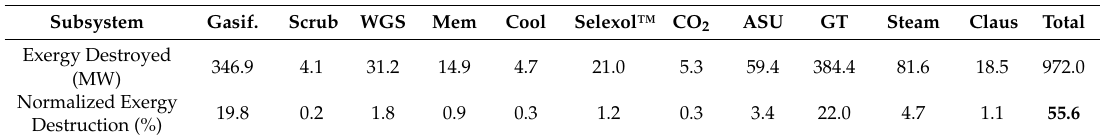
Table 8. Hydrogen membrane model results, assigning exergy destruction associated with heat transfer to/from the Steam subsystem to the non-Steam subsystem.